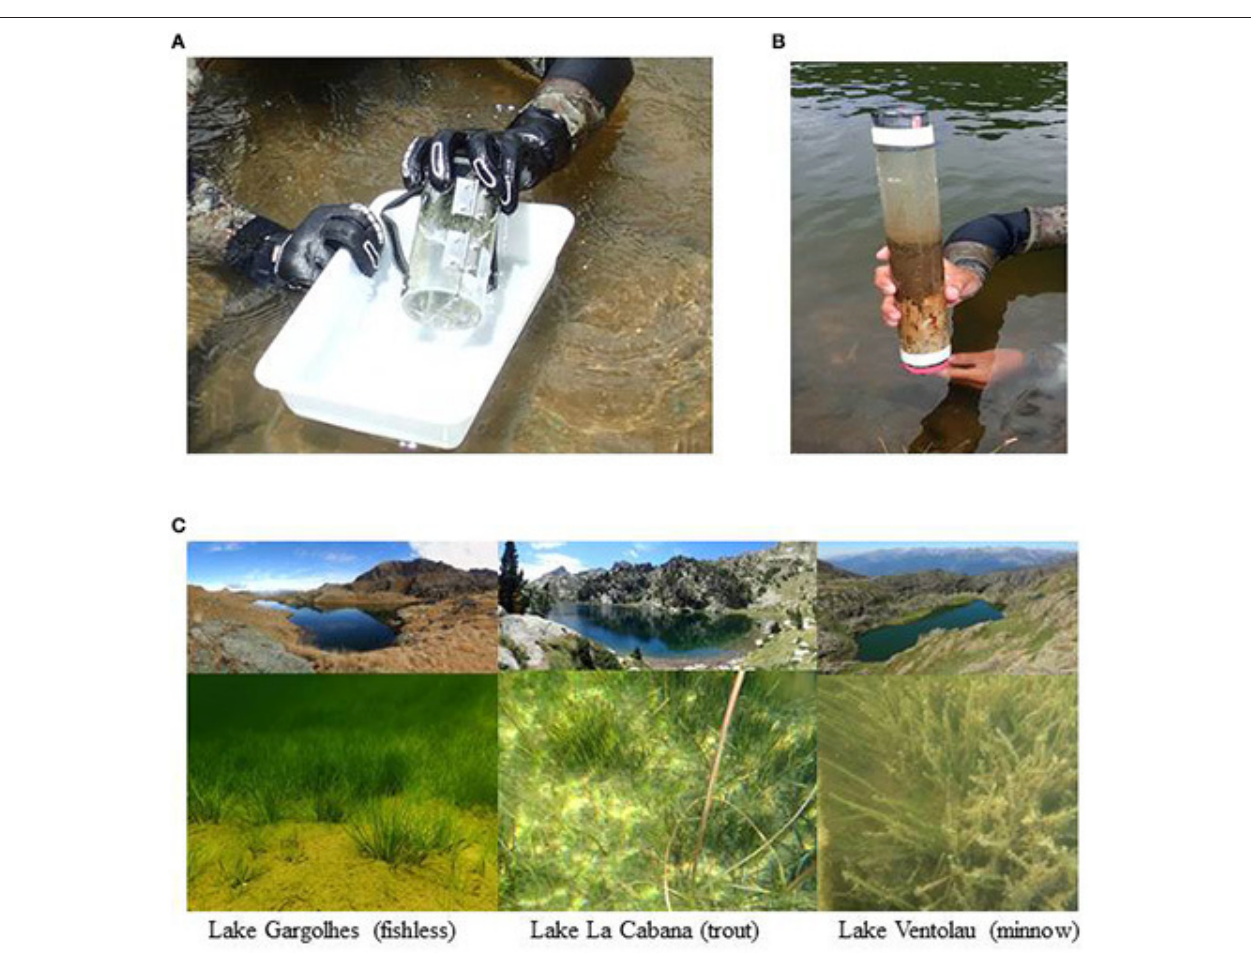
FIGURE 2 | Cylindrical section dredge used to collect quillwort leaves (A) and a core of sediment from Tres Estanys (B ; minnow lake) were different phases of the water-sediment interphase can be distinguished. Lake scenarios under examination (C) with an underwater view of the quillwort